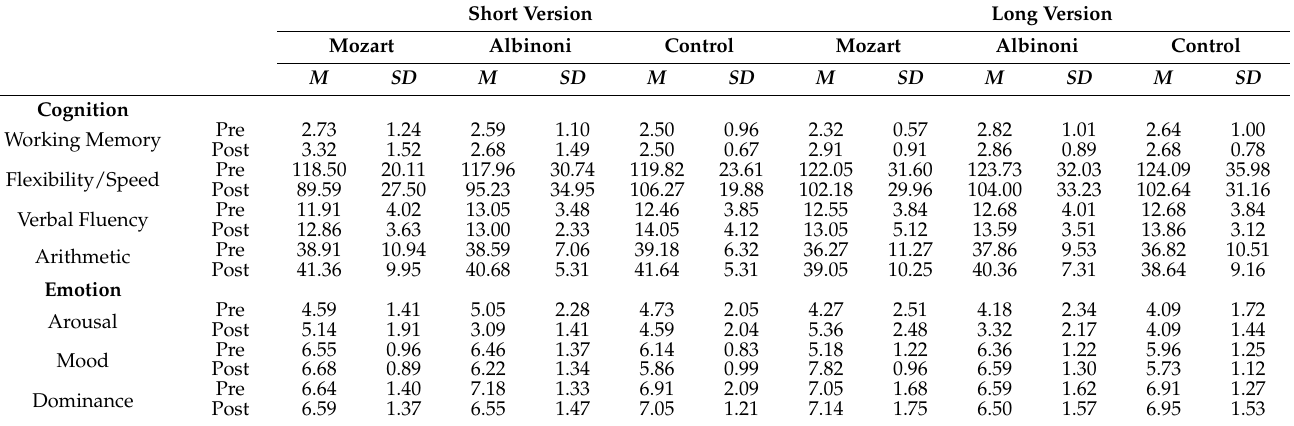
Table 1. Descriptive statistics ( M and SD ) for measures of cognition and emotion at pre- and post-test 1 . Short Version Long Version